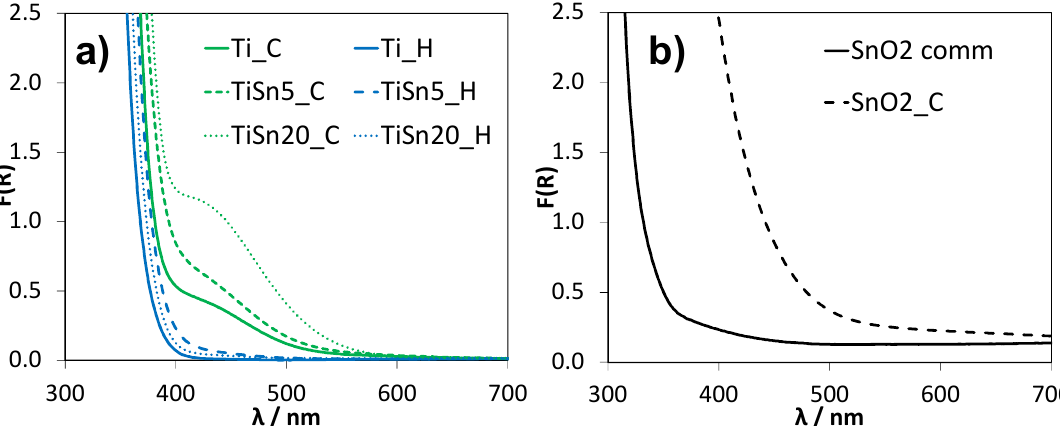
Figure 5. Normalized diffuse reflectance spectra (Kubelka–Munk function vs. wavelength) of pristine and Sn-promoted TiO 2 samples ( a ) and SnO 2 samples ( b ).